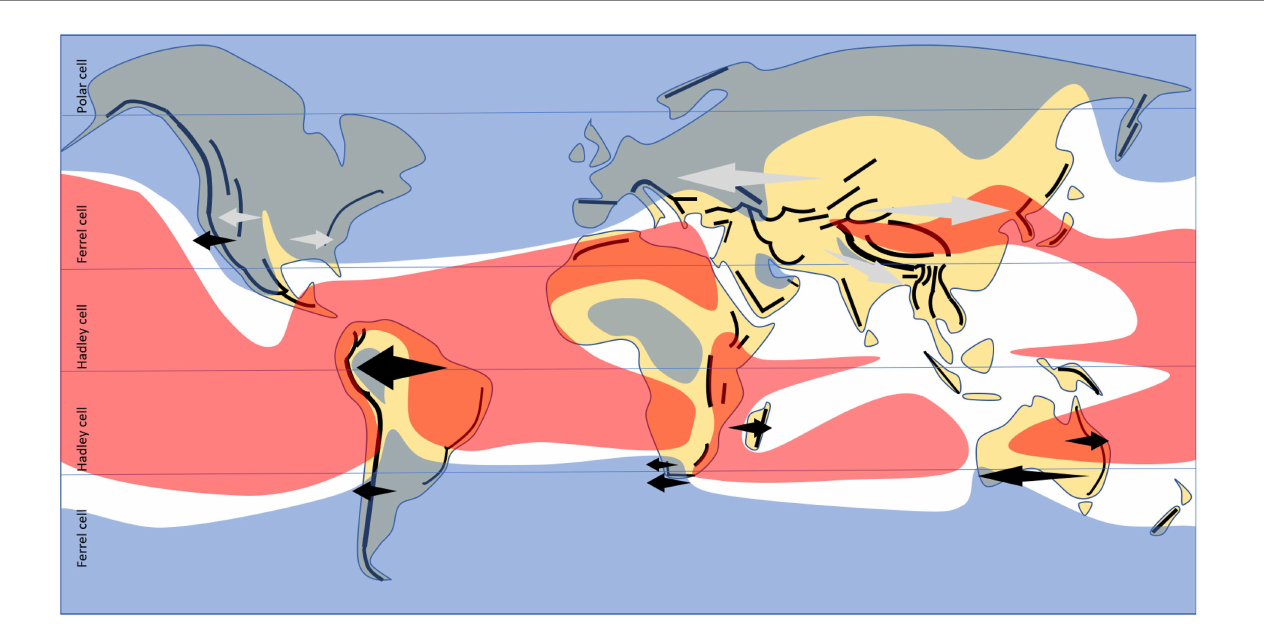
FIGURE 3 Documented longitudinal gradients in species diversity and endemism (arrows), as mentioned in the text, in relation to present-day continental arrangement, major mountain chains, and predominant direction of tropospheric circulation (westerlies in blue, easterlies in red, otherwise seasonally- varying (Oliver, 1987; Hu et al., 2020); horizontal lines indicate limits between tropical Hadley atmospheric cells – mostly easterlies, and temperate Ferrel cells – mostly westerlies). Black arrows indicate gradients with a strong endemism component, involving both nestedness and turnover; grey (continentality) patterns are mostly